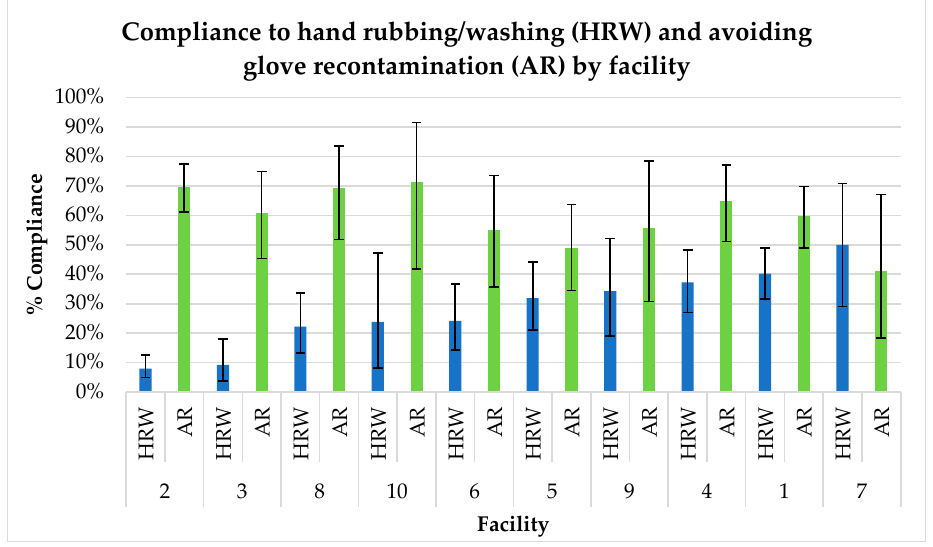
Figure 1. Compliance by facility. Table 2. Distribution of the categorical modifiable variables by facility for each of our two datasets: hand rubbing/washing dataset ( N = 779) and avoiding glove recontamination ( N = 449). Categorical Modifiable